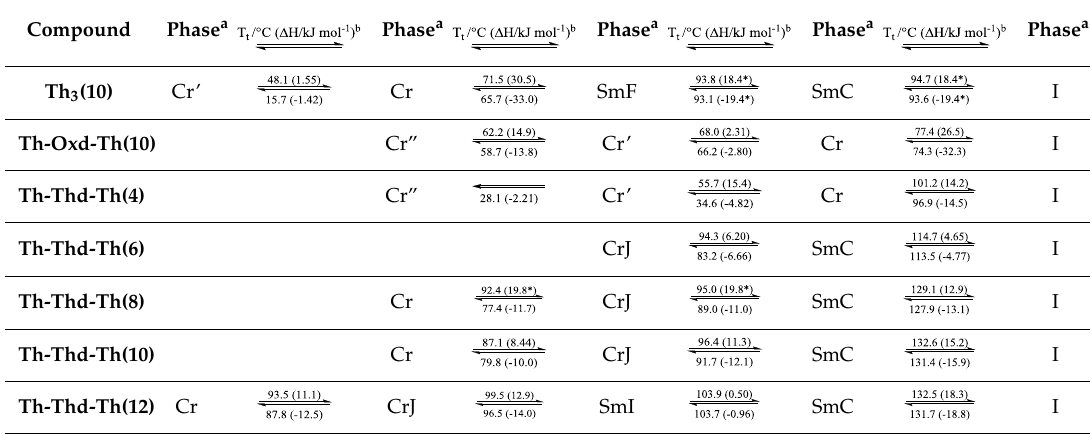
Table 1. Phase behaviour of the compounds studied.